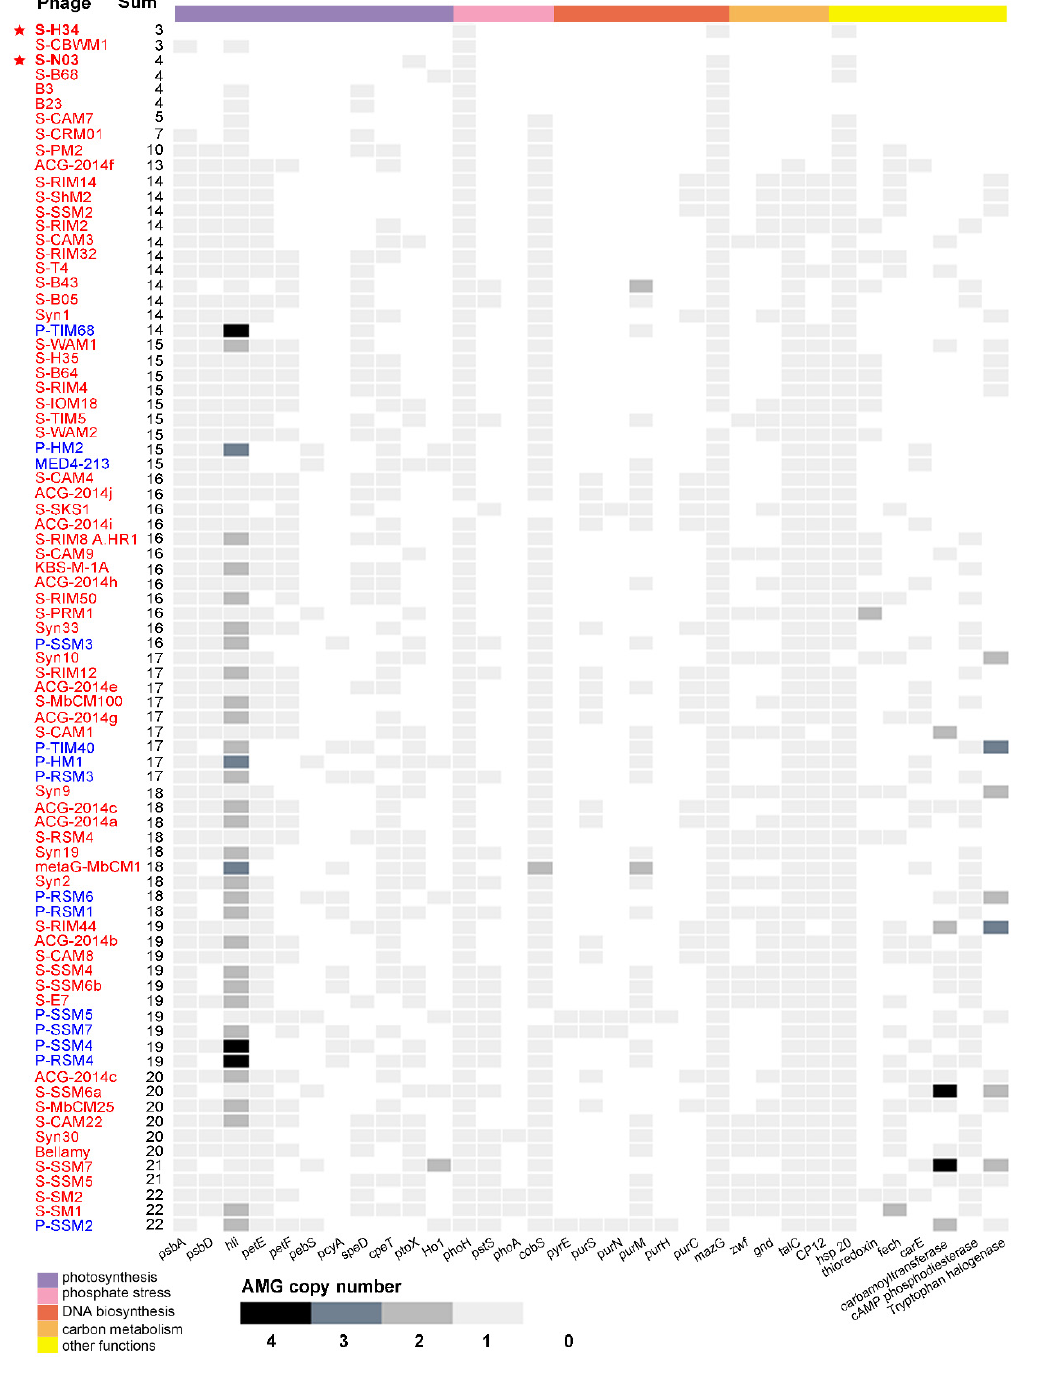
Figure 3. A heat map of gene copy number matrix for 33 auxiliary metabolic genes (AMGs) across 81 representative genomes of isolated cyanomyoviruses with available complete genome in NCBI. The AMG content was listed in an ascending order. The names of the cyanophages are colored separately by the originally isolated genus of the host: Synechococcus is red and Prochlorococcus is blue.